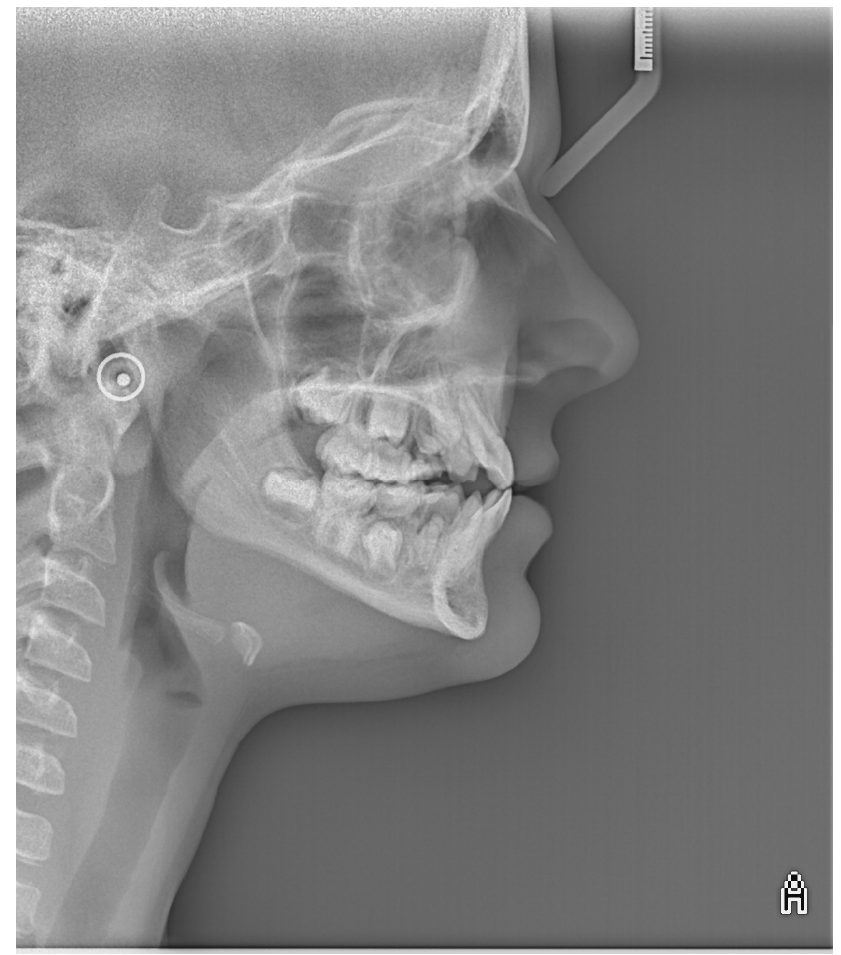
Figure 6. Image of lateral cephalometric radiograph.